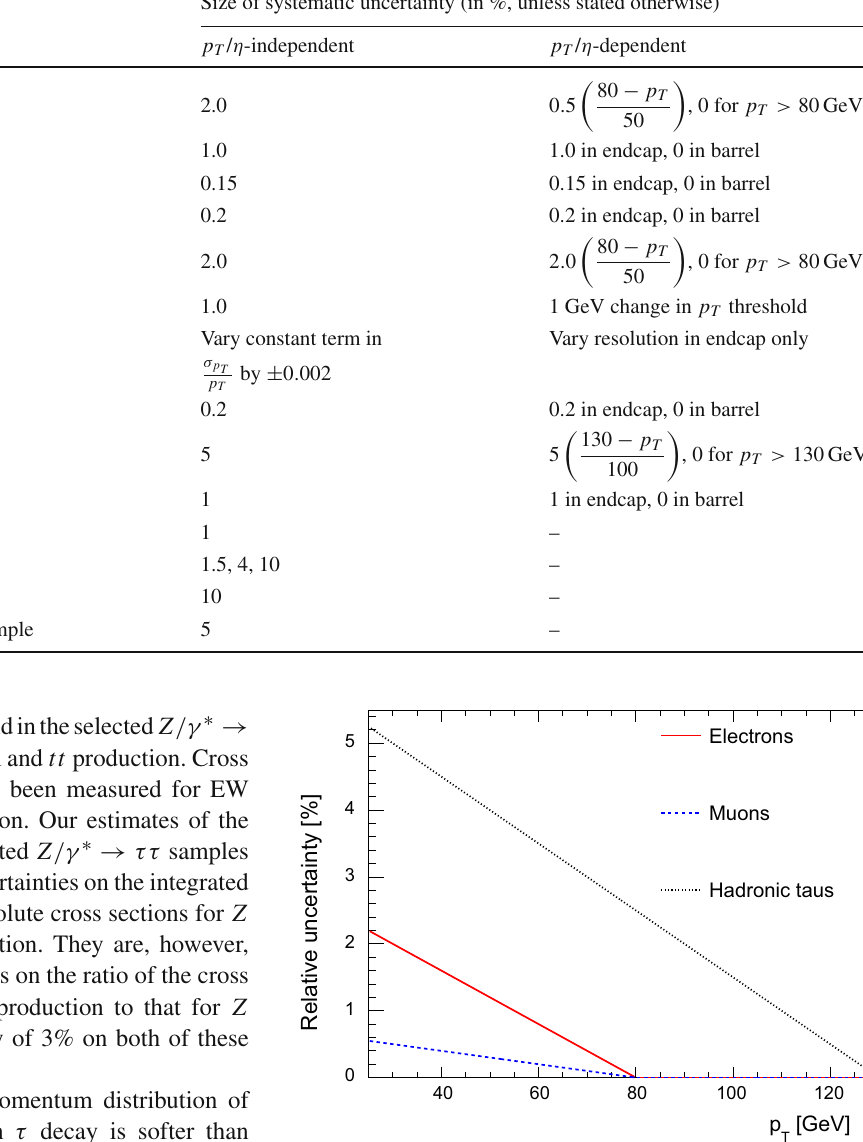
for the visible τ had systems. The relative acceptance for tt → bb (cid:2)τ had and tt → bbe μ final states may be